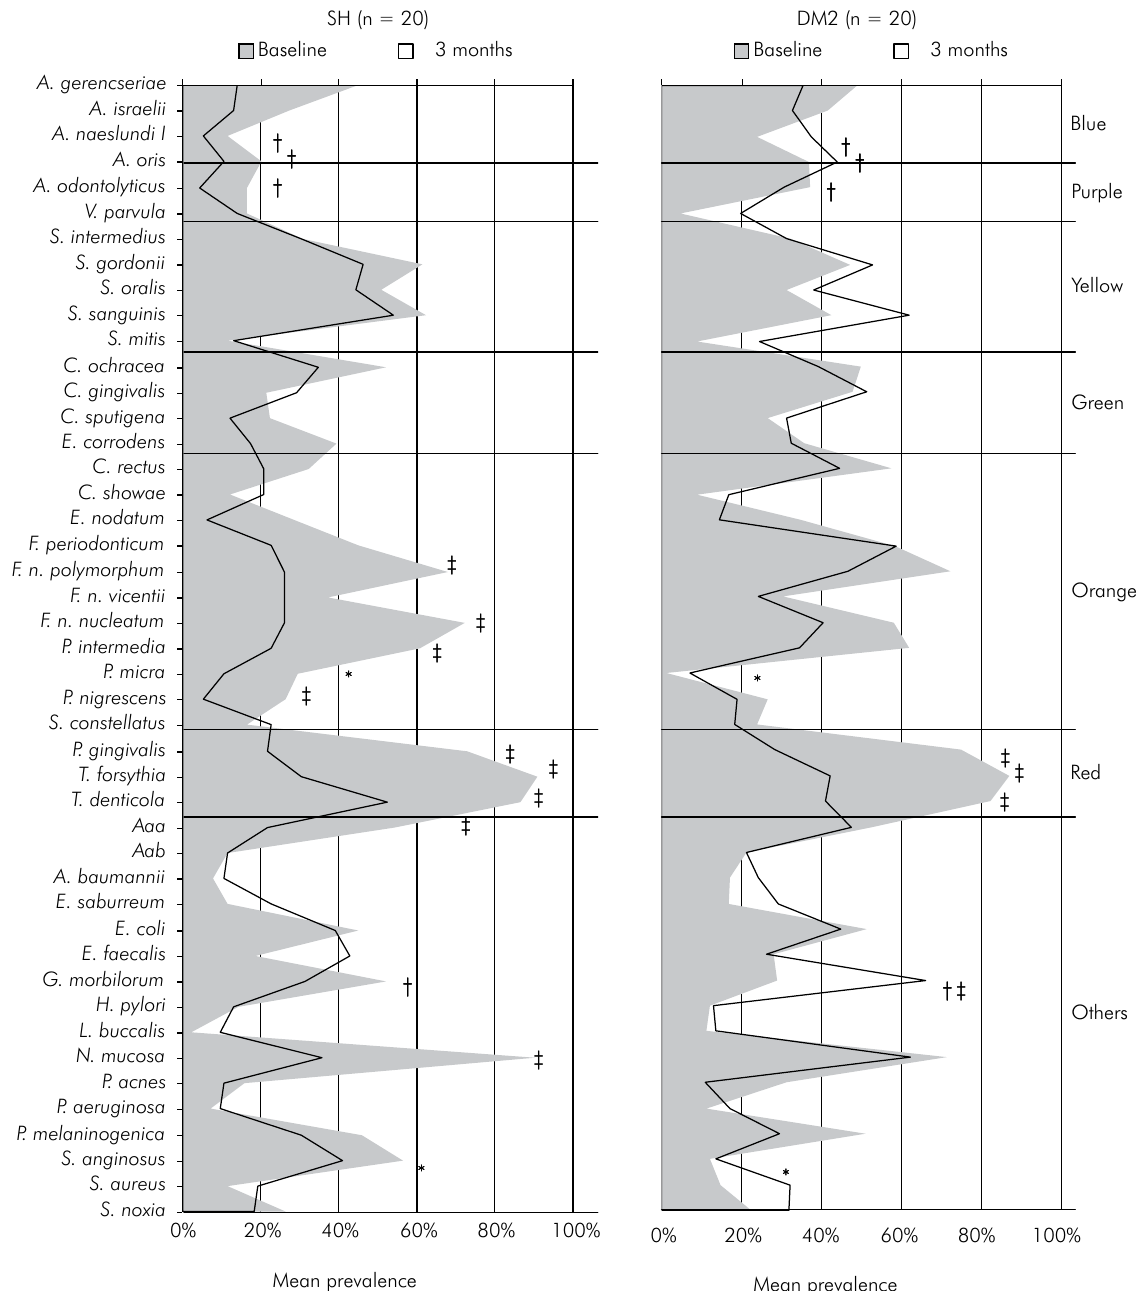
Figure 1. Mean prevalence of subgingival species evaluated in biofilm samples from individuals with type 2 diabetes (DM2) and systemically healthy (SH) individuals with chronic periodontitis, at baseline and 3 months after SRP. The species were ordered according to the bacterial complexes. 25 Aa: Aggregatibacter